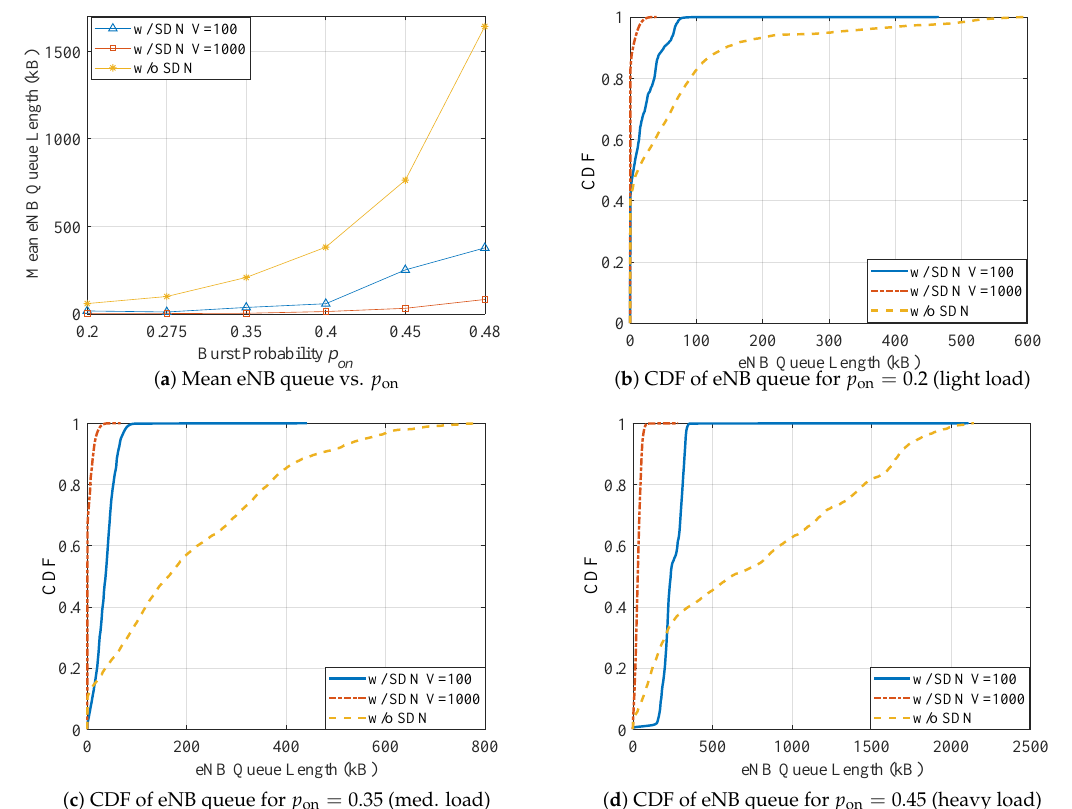
Figure 6. Mean and CDF of eNB queue length in kB for O = 2 operators with random traffic burst as a function of steady-state probability p on of burst